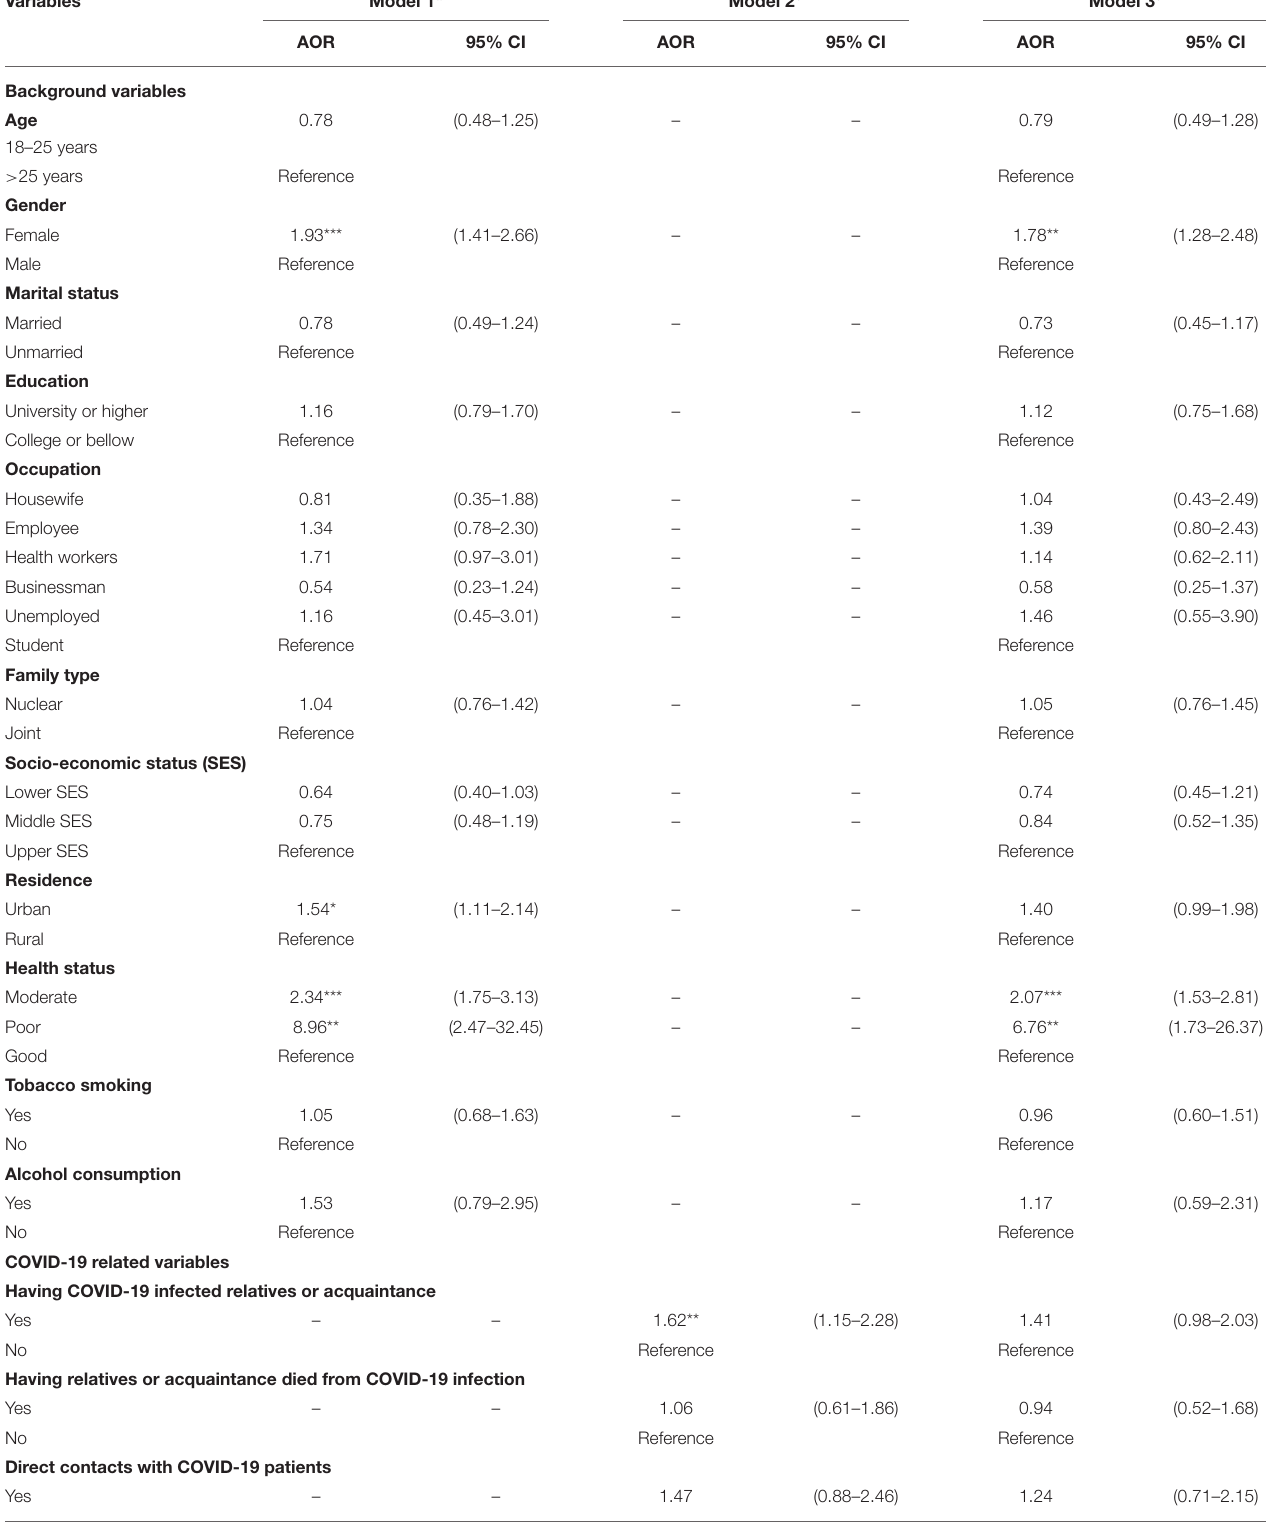
TABLE 2 | The multivariable analyses of all the variables by poor sleep